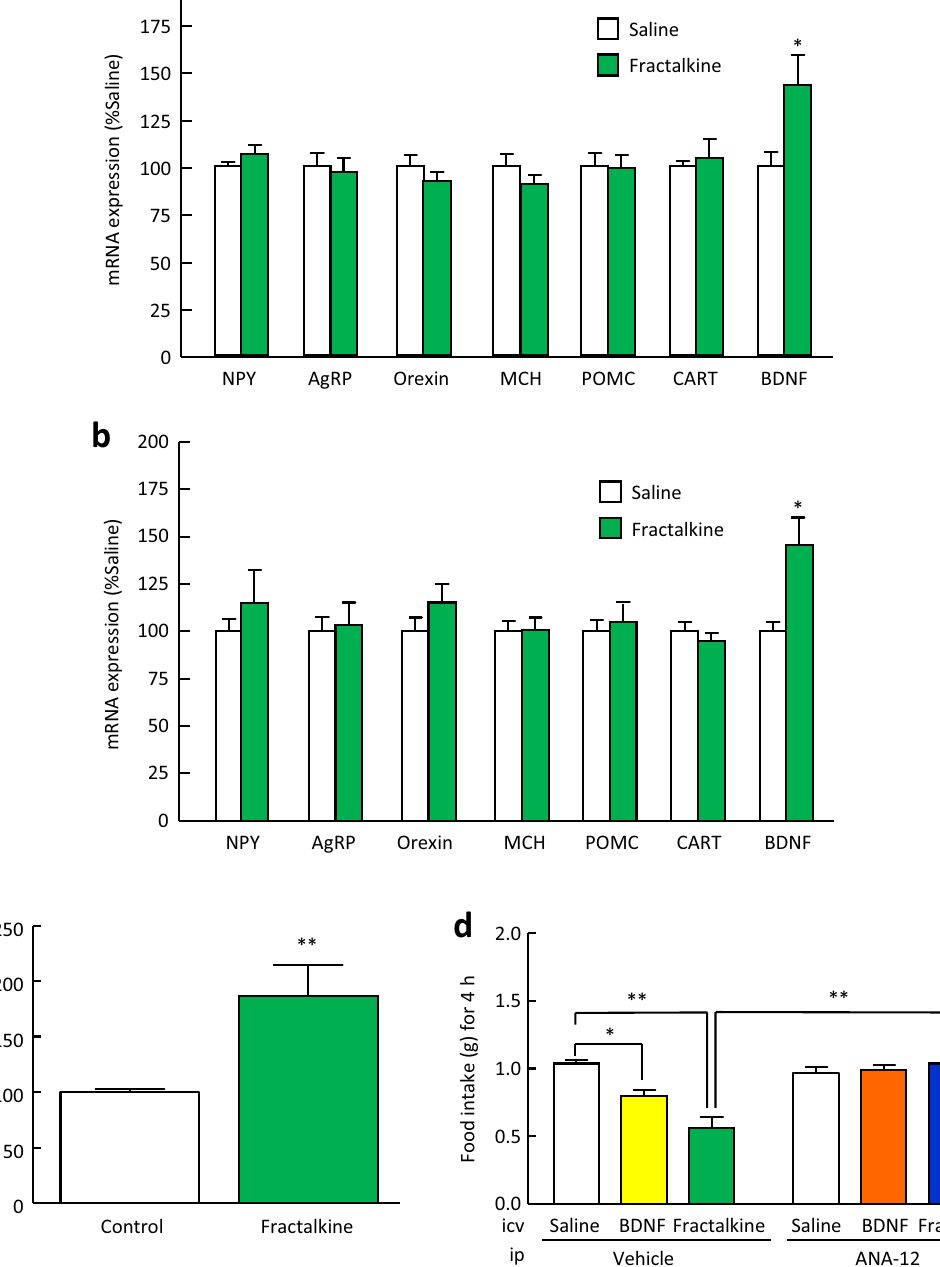
Figure 3. Involvement of BDNF in the anorexigenic effect of fractalkine in mice. ( a ) mRNA expression in the hypothalamus of normal mice was examined at 4 h after intracerebroventricular administration of fractalkine (3 μg/mouse). ( b ) mRNA expression in the hypothalamus of refed mice was examined at 4 h after intracerebroventricular administration of fractalkine. Fractalkine (3 μg/mouse) was intracerebroventricularly administered before 4-h refeeding after 48-h fasting. ( c ) BDNF mRNA expression in MG6 cells was examined after application of fractalkine (100 nM) for 3 h. ( d ) TrkB antagonist ANA-12 (0.5 mg/kg) was intraperitoneally administered at 30 min before intracerebroventricular administration of fractalkine (3 μg/mouse) and BDNF (0.5 μg/mouse). Results are expressed as mean ± SEM for 6–14 mice. Significant differences: * p < 0.05, ** p <